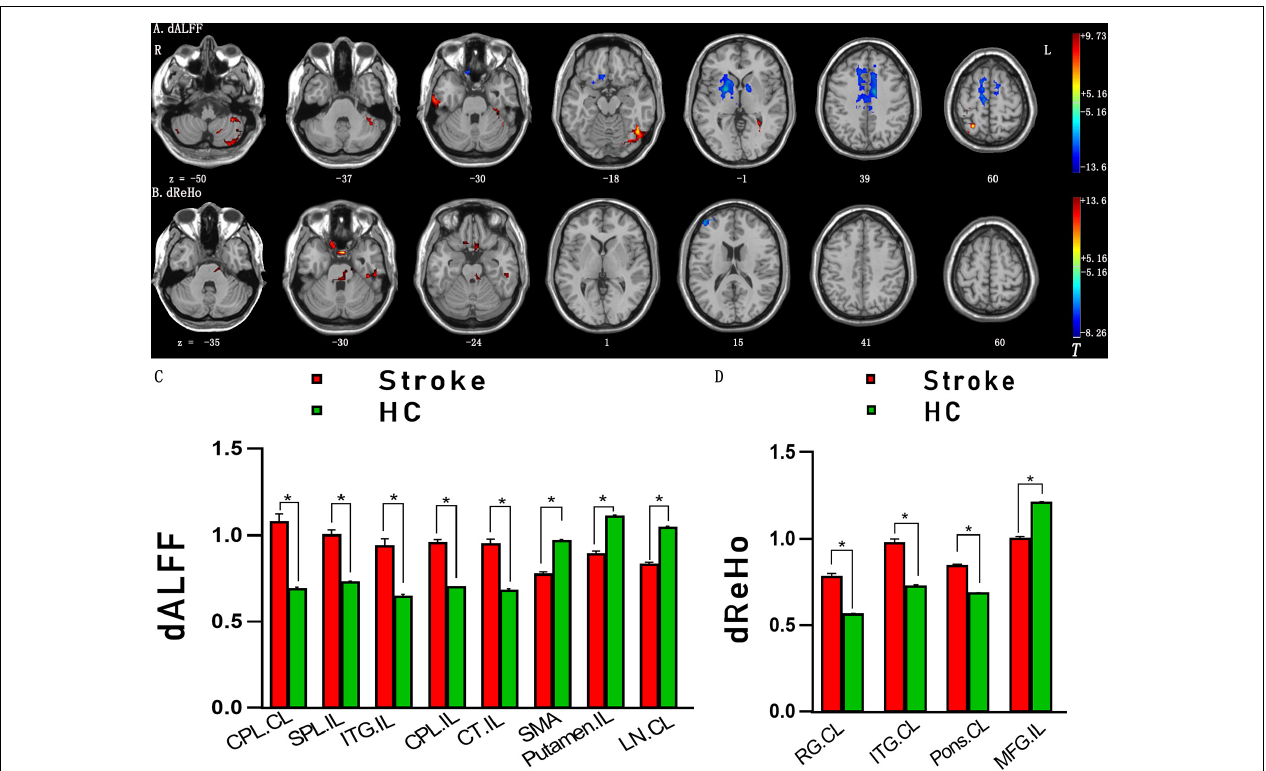
FIGURE 2 | (A) Brain regions with significant intergroup differences in dALFF between the stroke group and HC group. (B) Brain regions with significant intergroup differences in dReHo between the stroke group and HC group. (C) The histogram indicates mean values and standard error of dALFF variability between the stroke group and HC group. (D) The histogram indicates mean value and standard error of dReHo variability between the stroke group and HC group. Familywise error rate corrected ( p < 0.05, cluster size ≥ 50 voxels). The color bar indicates the T value. ∗ p < 0.05. HC, healthy controls; dALFF, dynamic amplitude of low-frequency fluctuation; dReHo, dynamical regional homogeneity; CPL, cerebellum posterior lobe; SPL, superior parietal lobe; ITG, inferior temporal gyrus; CT, cerebellum tonsil; SMA, supplementary motor area; LN, lentiform nucleus; RG, rectal gyrus; MFG, middle frontal gyrus; IL, ipsilesional; CL,